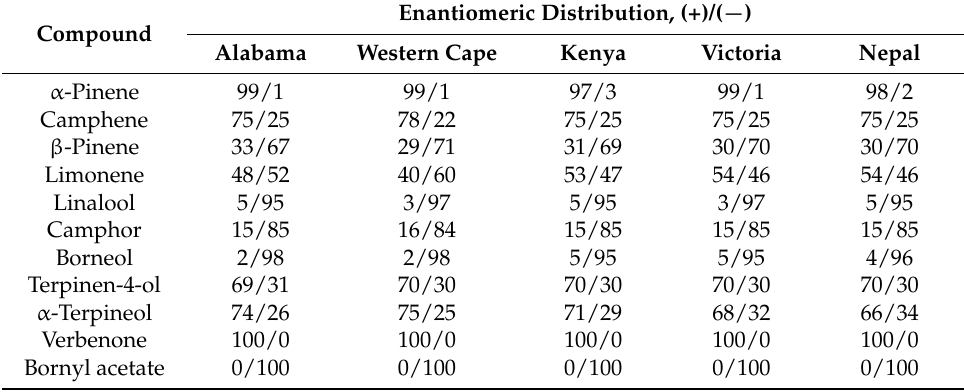
Table 2. Enantiomeric distribution of monoterpenoids in Rosmarinus officinalis essential oils from six different geographical